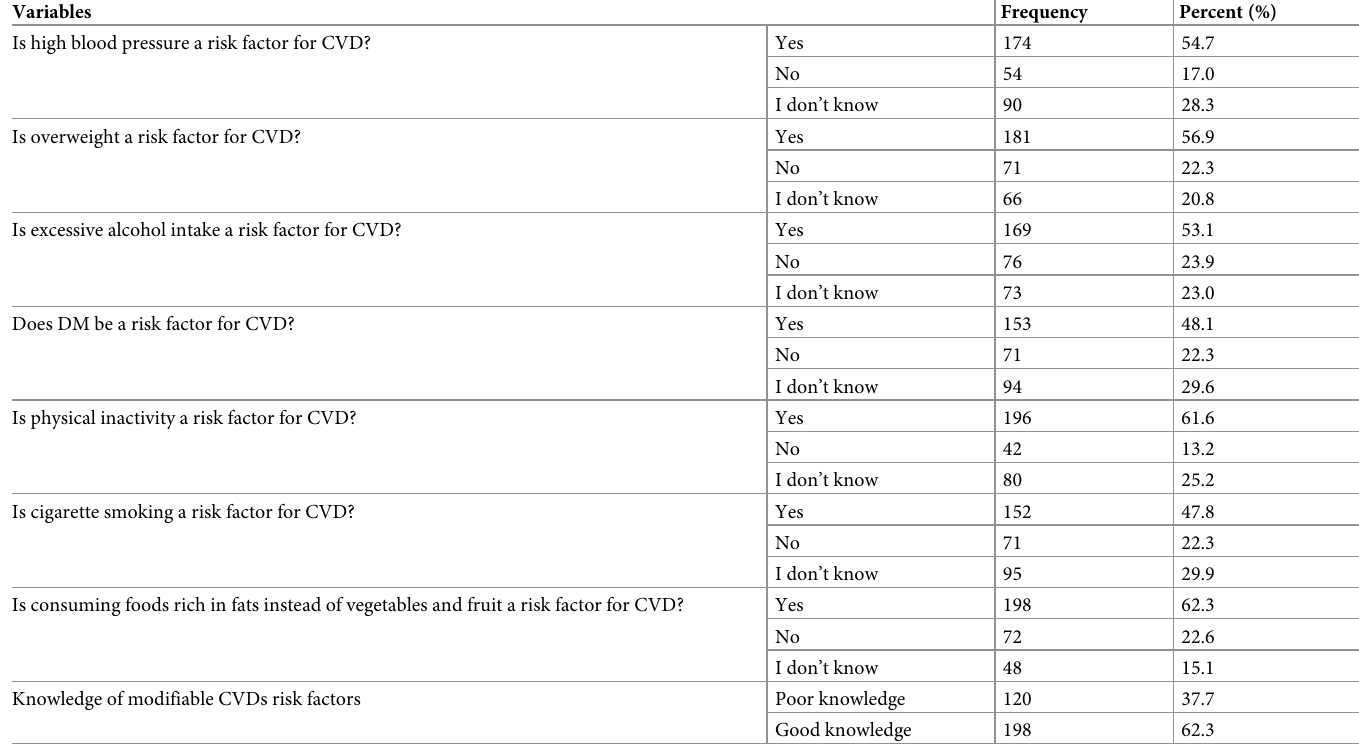
Table 2. Knowledge of modifiable cardiovascular diseases risk factors among diabetic mellitus patients who were on follow-up at Jimma University Medical Centre, 2021. Variables Frequency Is high blood pressure a risk factor for CVD?